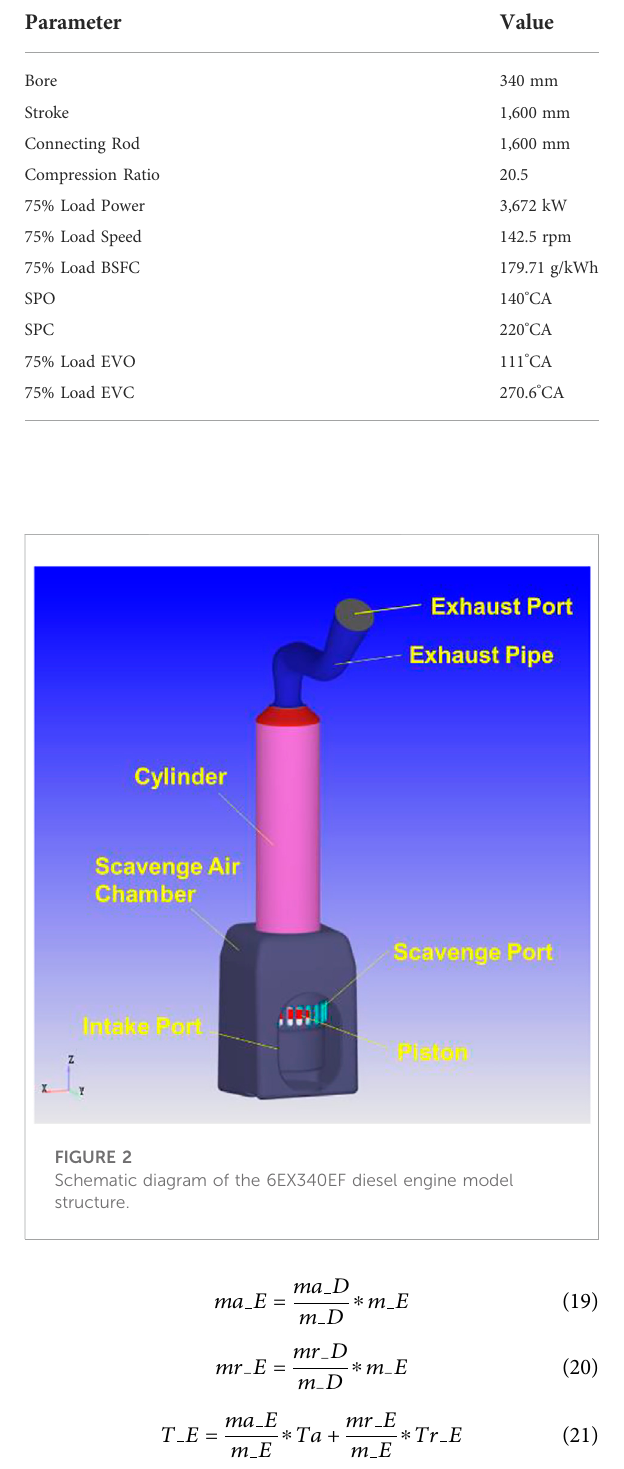
TABLE 3 Mesh number and calculation time